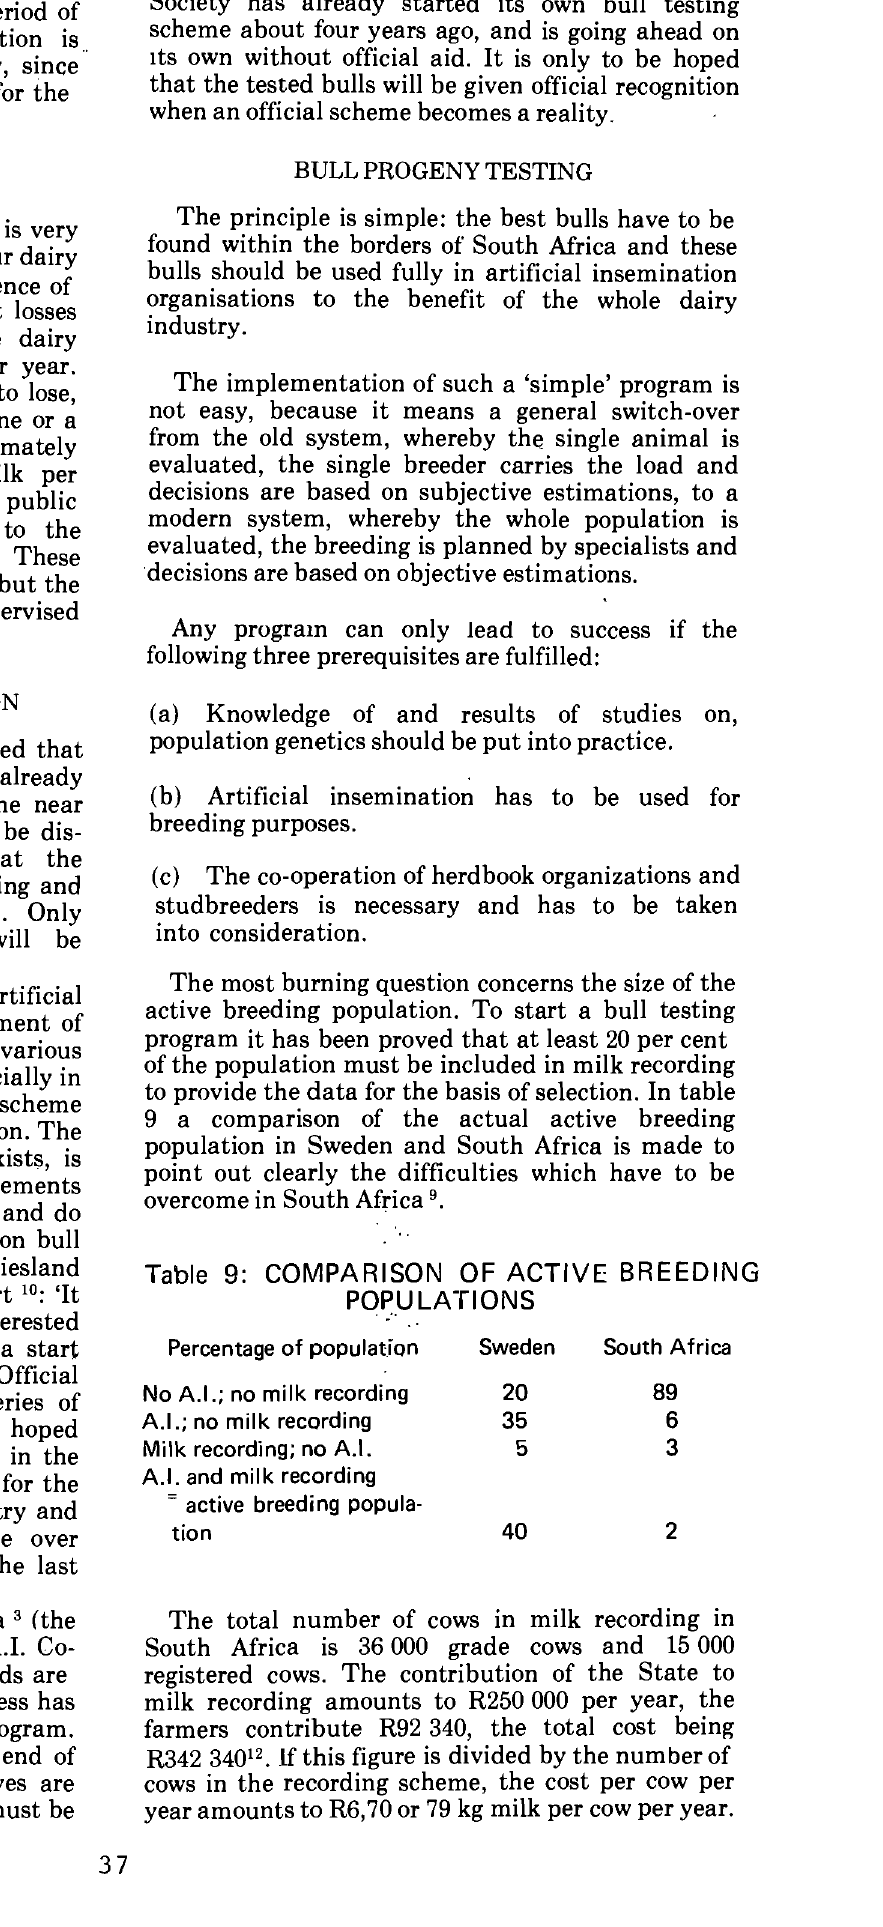
Table 9: COMPARISON OF ACTIVE BREEDING